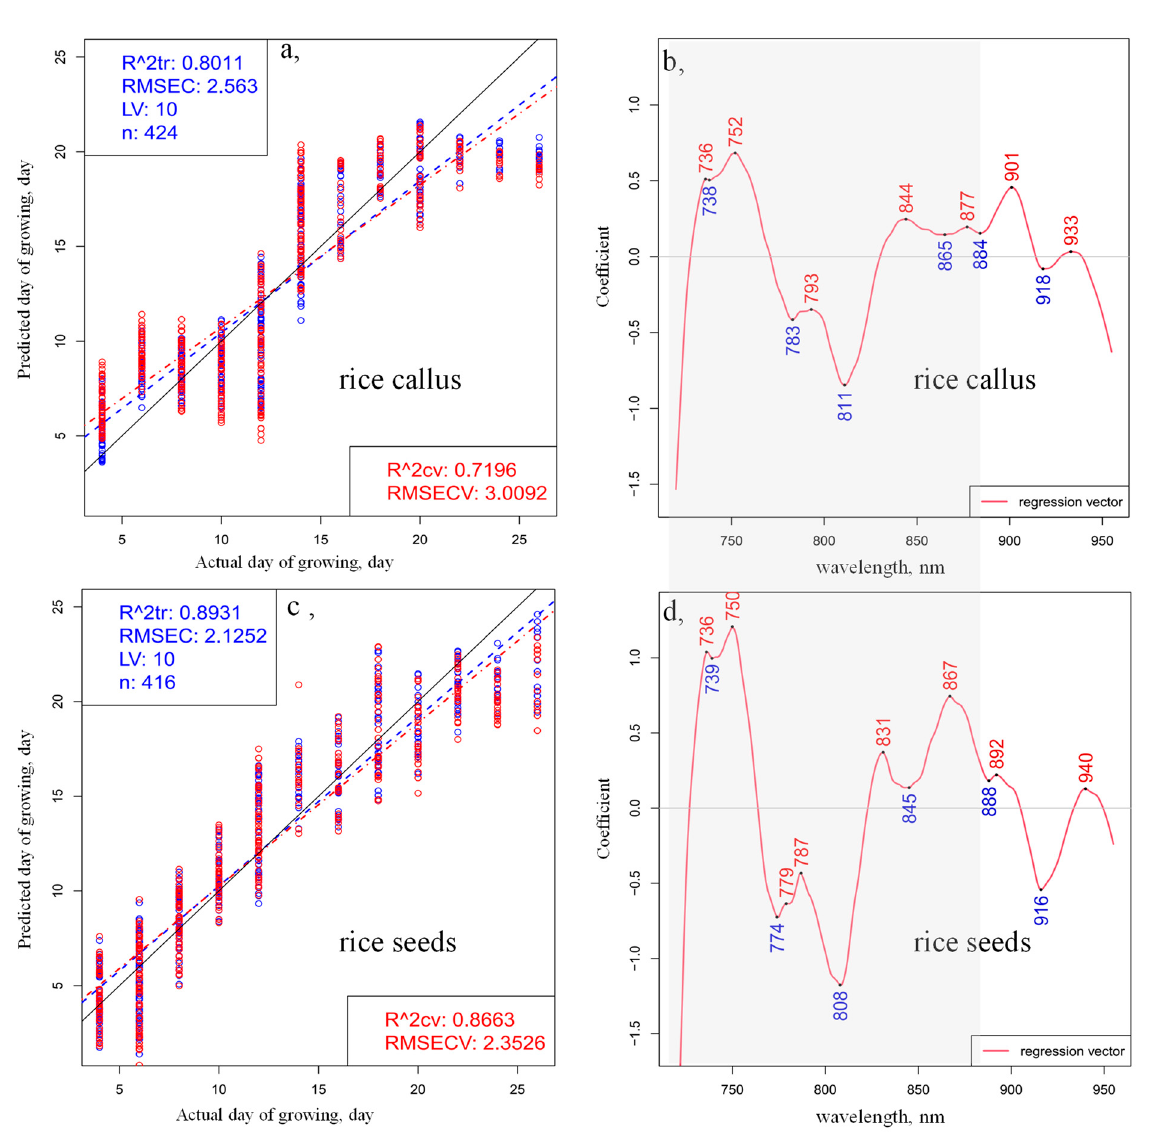
Figure 2. PLSR analysis using time as a dependent variable (the day of development) performed on the preprocessed (smoothing, SNV and linear detrend) transmittance spectra in the spectral range between 720 and 955 nm of ( a ) 28 callus samples and ( c ) 28 rice seedlings; regression vector of the PLSR models for ( b ) callus samples and ( d ) rice seedlings (blue circles indicate the calibration and red circles the cross-validation data points; blue dashed lines indicate the calibration Y-fit and red dashed lines the cross-validation Y-fit, while black continuous lines show the Y-fit of ideal prediction).